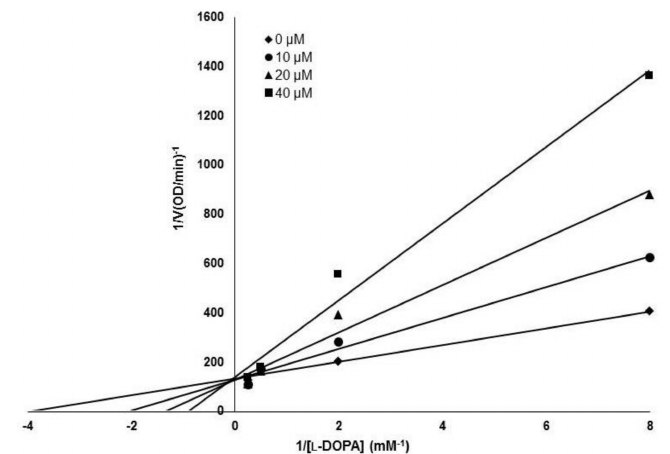
Figure 3. Lineweaver–Burk plot for the tyrosinase inhibitory mechanism of MHY1498. Tyrosinase inhibition was examined at different concentrations (0, 10, 20 and 40 µ M); L -DOPA was used as a substrate for the